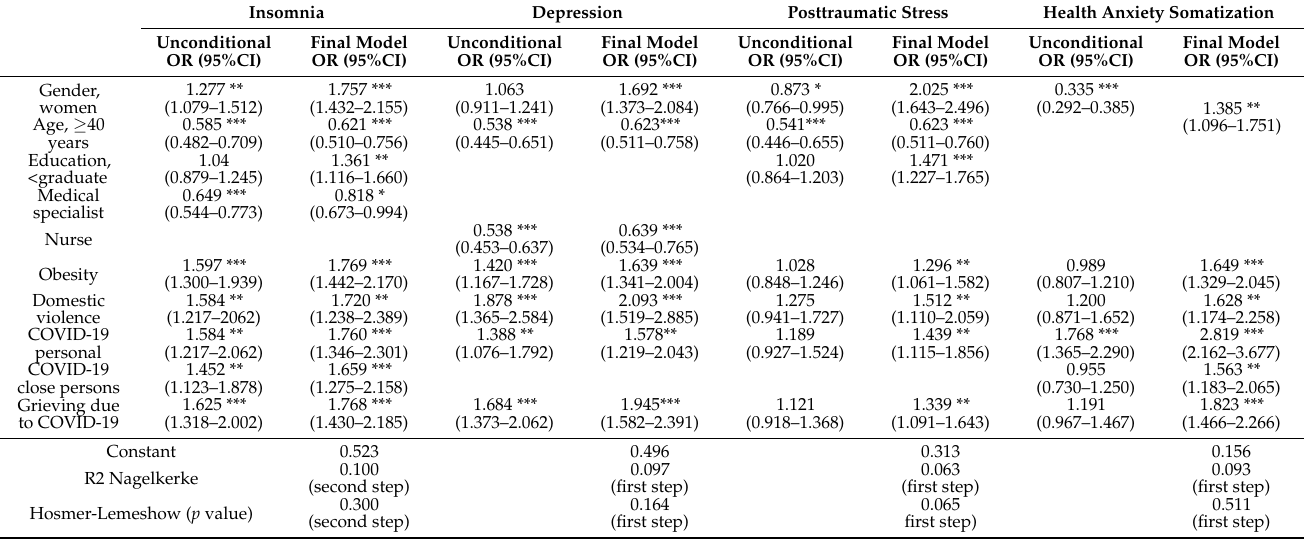
Table 4. Regression models to predict most frequent CMD in Mexican FHCWs during COVID-19 peak ( n =